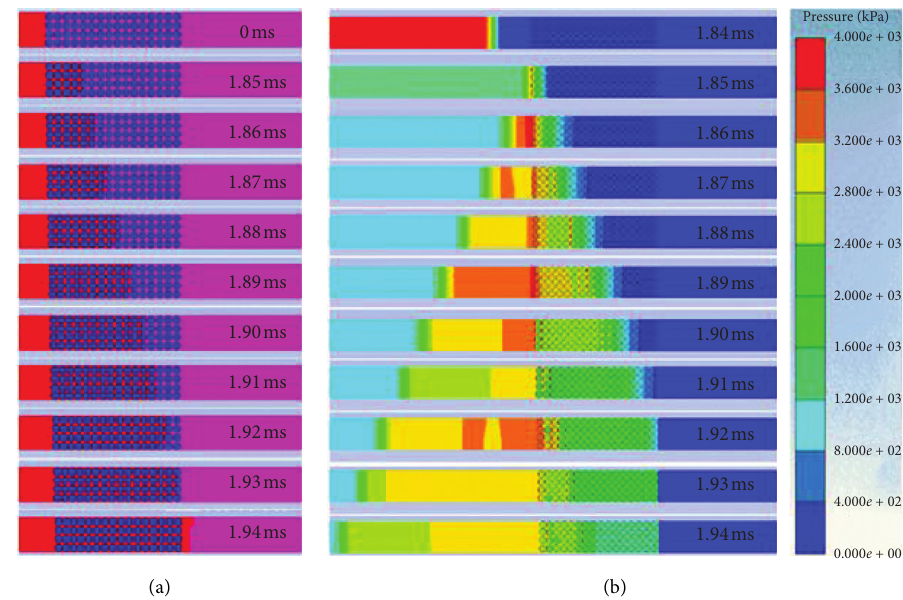
Figure 11: Gas percolation and pressure distribution in the particle pores.